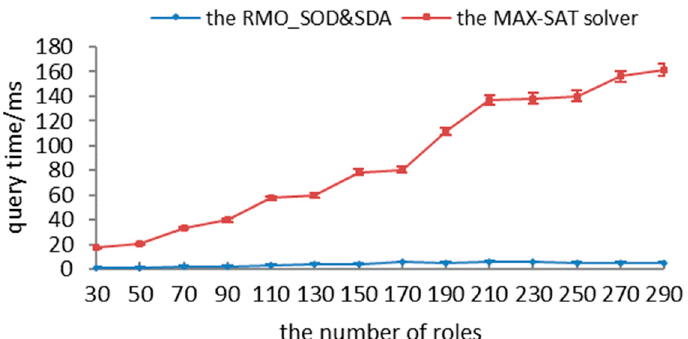
Figure 2. Query comparison when match = exact. MAX-SAT, maximal satisfiability.